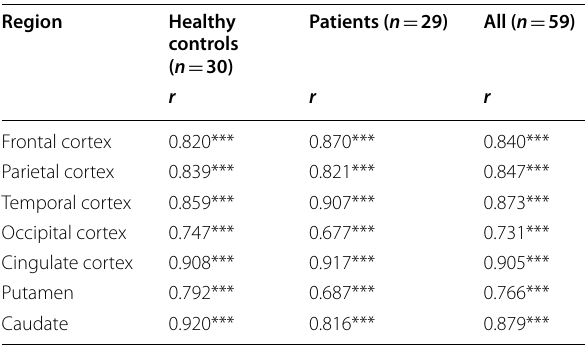
Table 3 Correlations between rCBF region